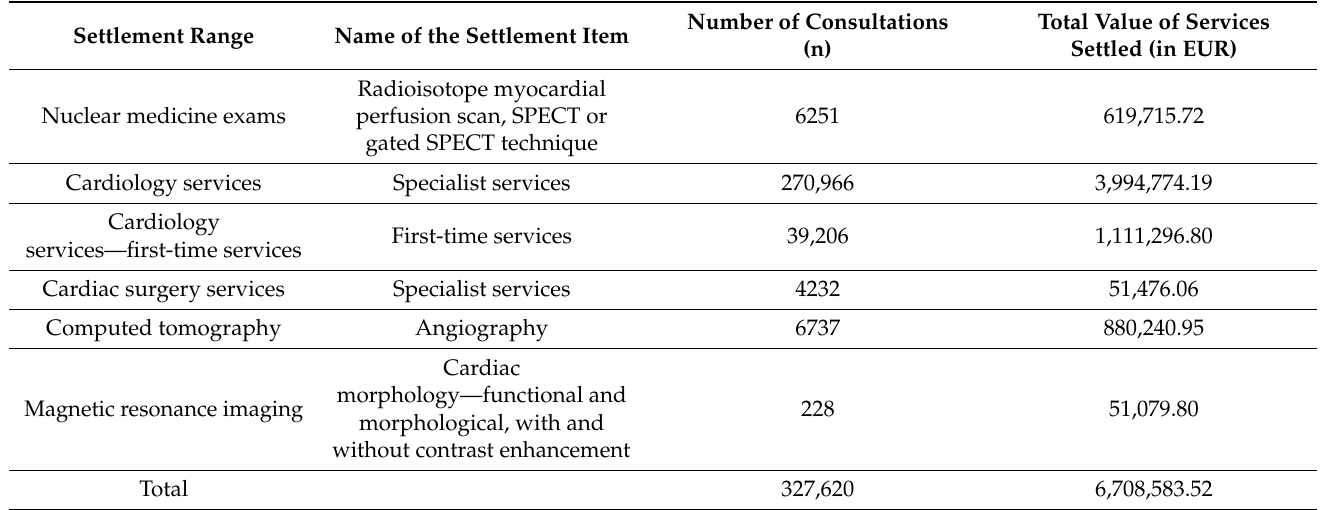
Table 5. Expenditure (in EUR) on outpatient specialist care for patients not covered by CCMI, organised by the most expensive settlement items.